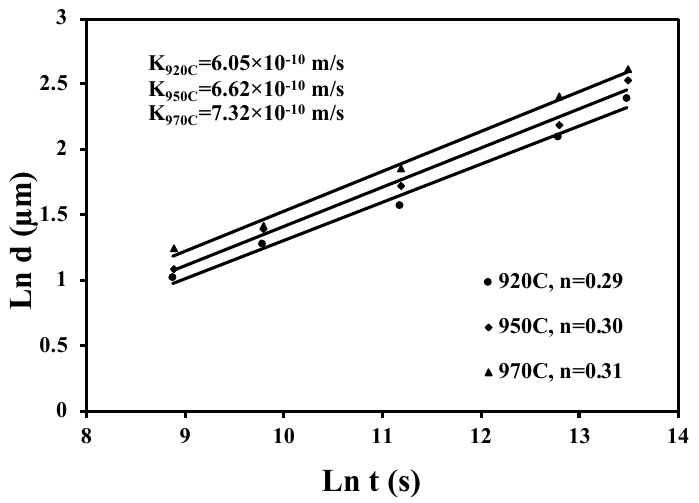
Figure 11. Plots of ln d vs. ln t to determine n and k at 920, 950, and 970 °C for the coarsening of the α + β microstructure in the LPBF Ti-6Al-4V ELI alloy.